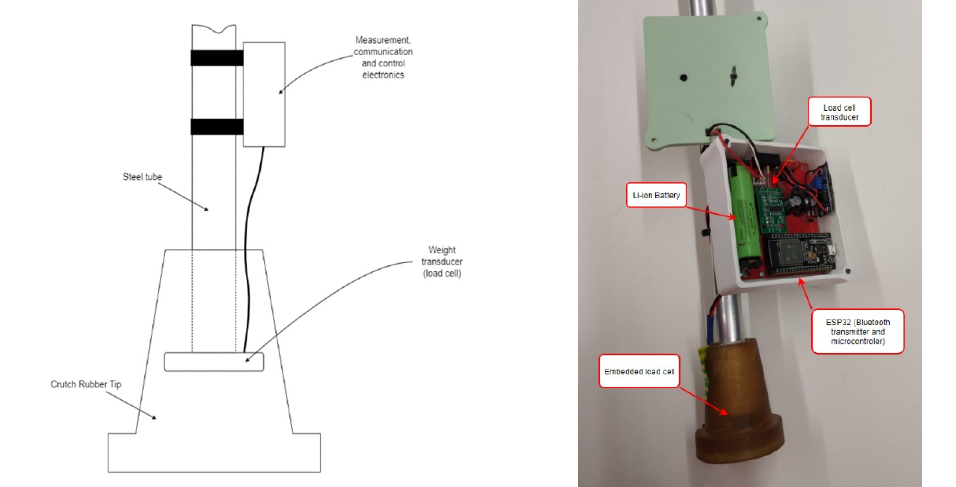
Figure 3. Diagram of the device ( left ) and device developed ( right ).